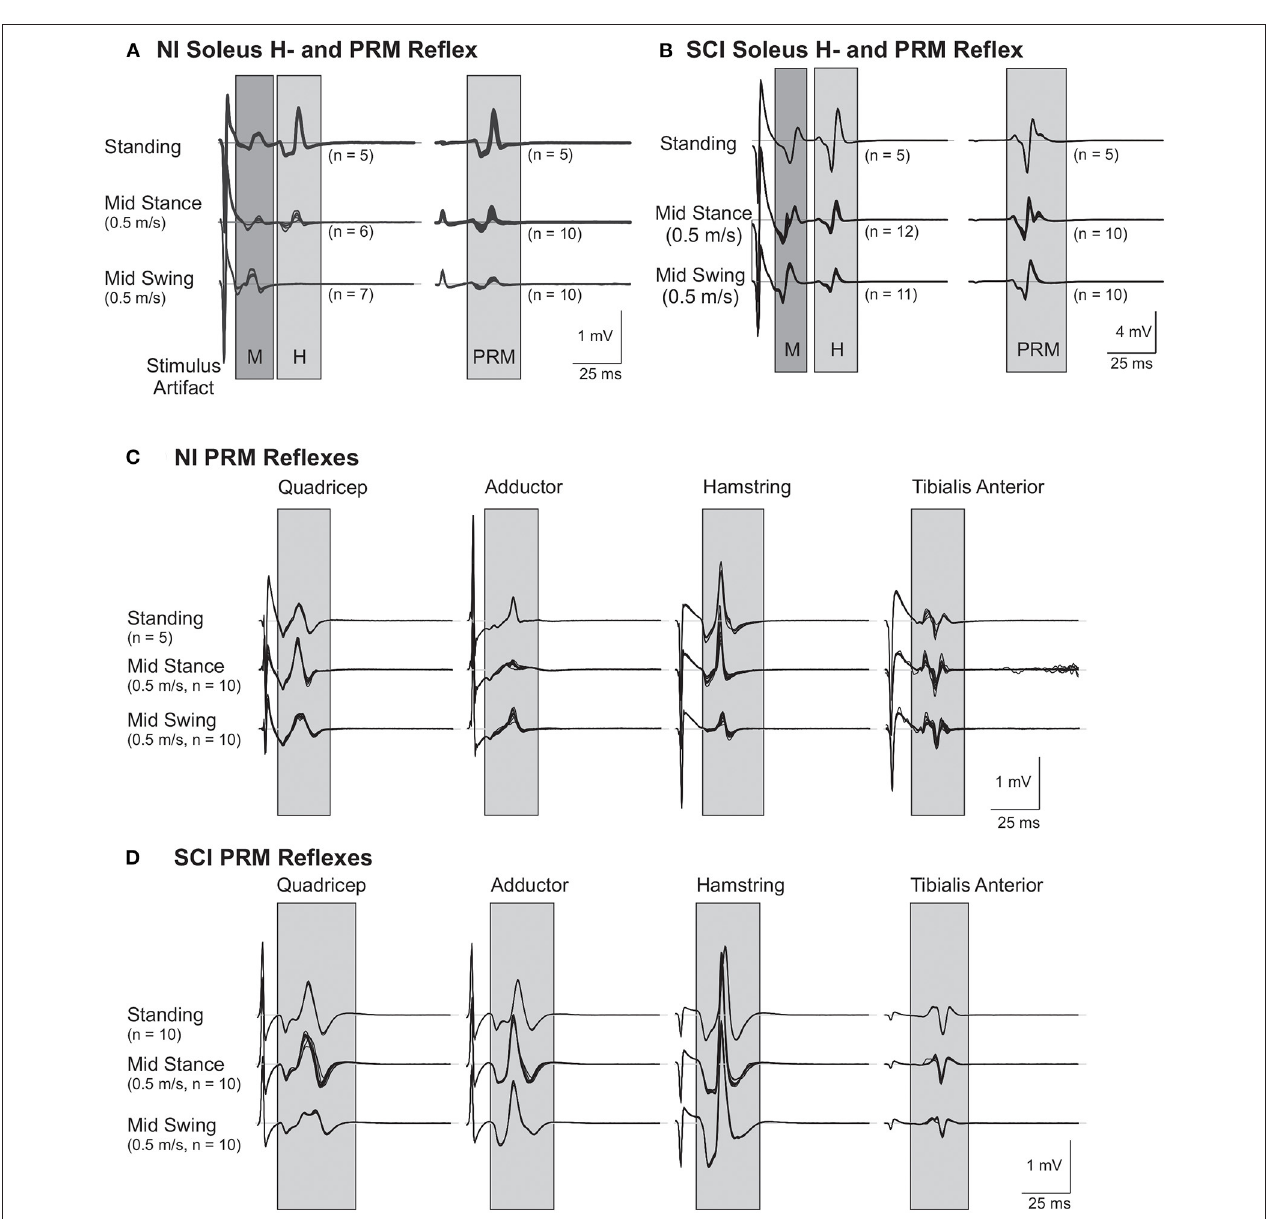
FIGURE 1 | Representative soleus H and lower limb posterior root muscle (PRM) Reflexes. (A,B) Soleus H and PRM reflexes from a subject without injury [NI#, (A) ] and a subject with a spinal cord injury [SCI#, (B) ]. Note the mid-swing reduction of H and PRM in the soleus is absent in the SCI subject. (C,D) PRM reflexes from other lower limb muscles: hip adductor (Adductor), rectus femoris (Quadriceps), biceps femoris anterior (Hamstring), and tibialis anterior from the same subject without injury (C) and the same subject with SCI (D) . Gray areas highlight the approximate time frame of the H and PRM